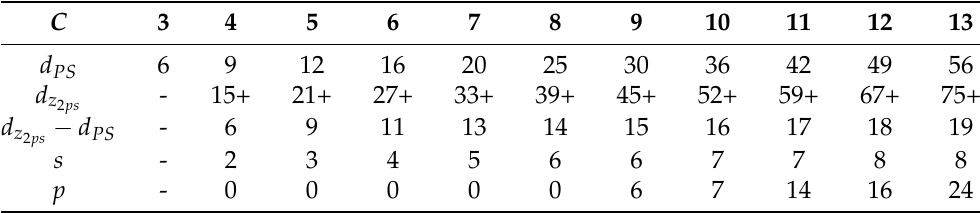
Table 2. Maximum available approximation order for a cost C in terms of matrix products using the Paterson–Stockmeyer method, denoted by d PS , the maximum order using S T − d denoted by d z , and the difference d z PS . Parameters s and p are used in z S T ST ST